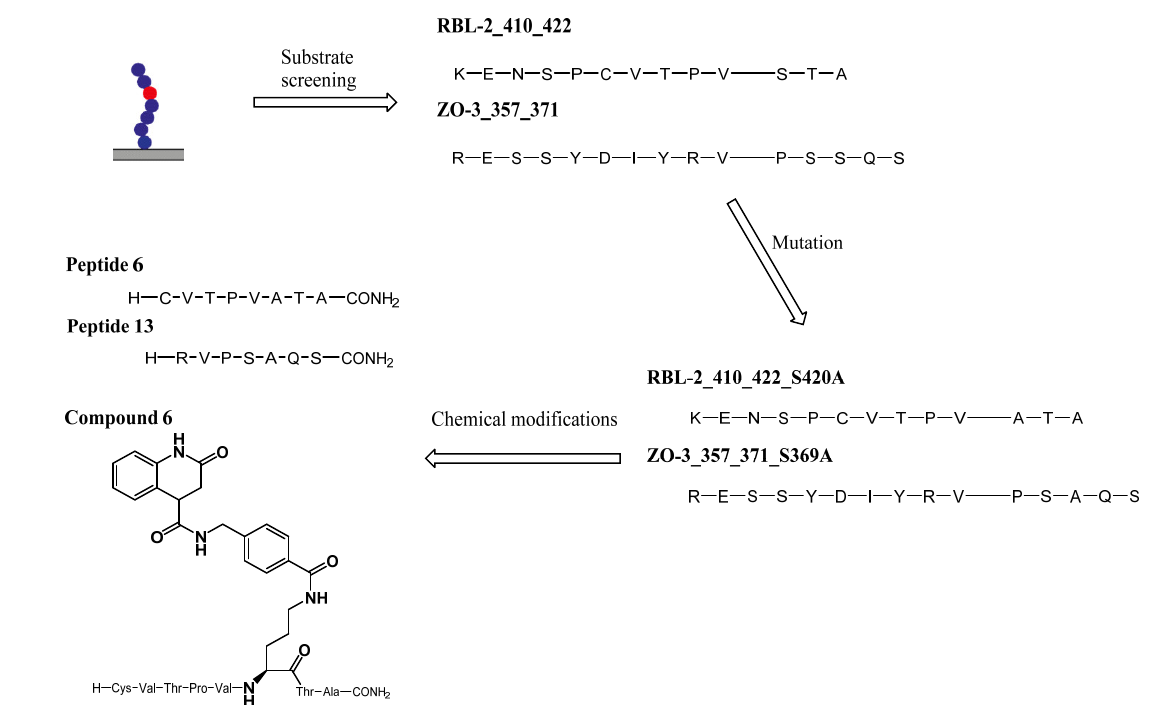
Figure 10. Development of peptidic and hybrid inhibtors of OGT starting with PamStation substrate screening.